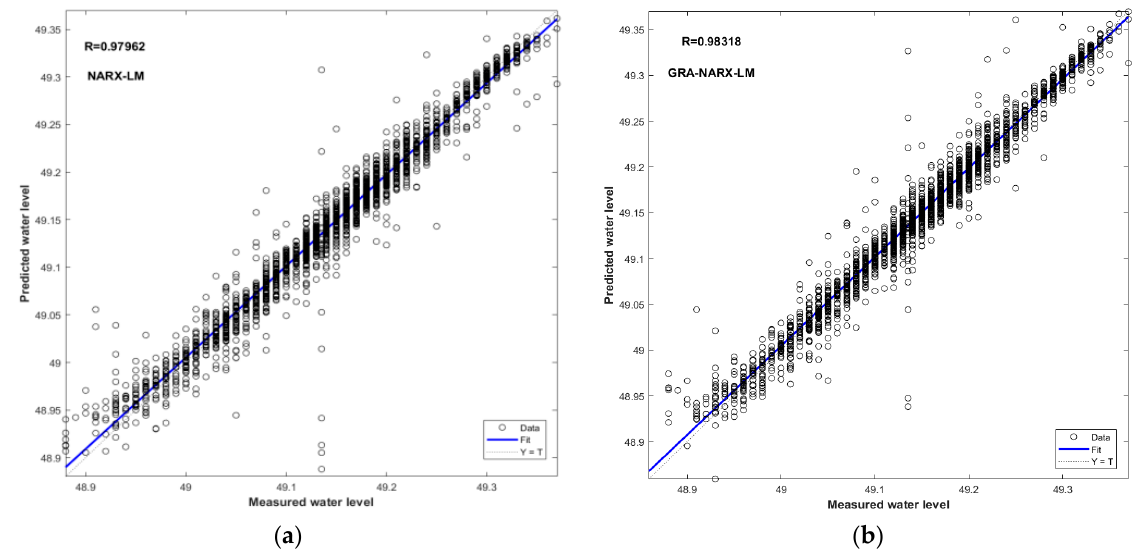
Figure 7. Scatter plots of measured and predicted water levels for the GRA-NARX and NARX models using LM as the training algorithm: ( a ) NARX-LM, ( b ) GRA-NARX-LM.